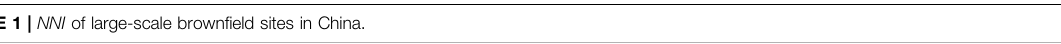
TABLE 1 | NNI of large-scale brown fi eld sites in